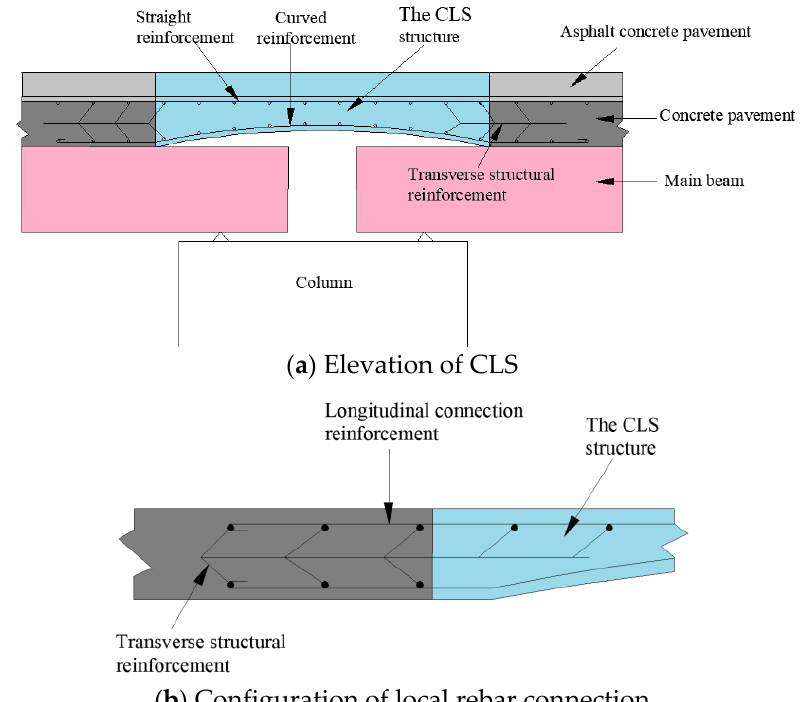
Figure 1. Structure of the reinforced concrete CLS.